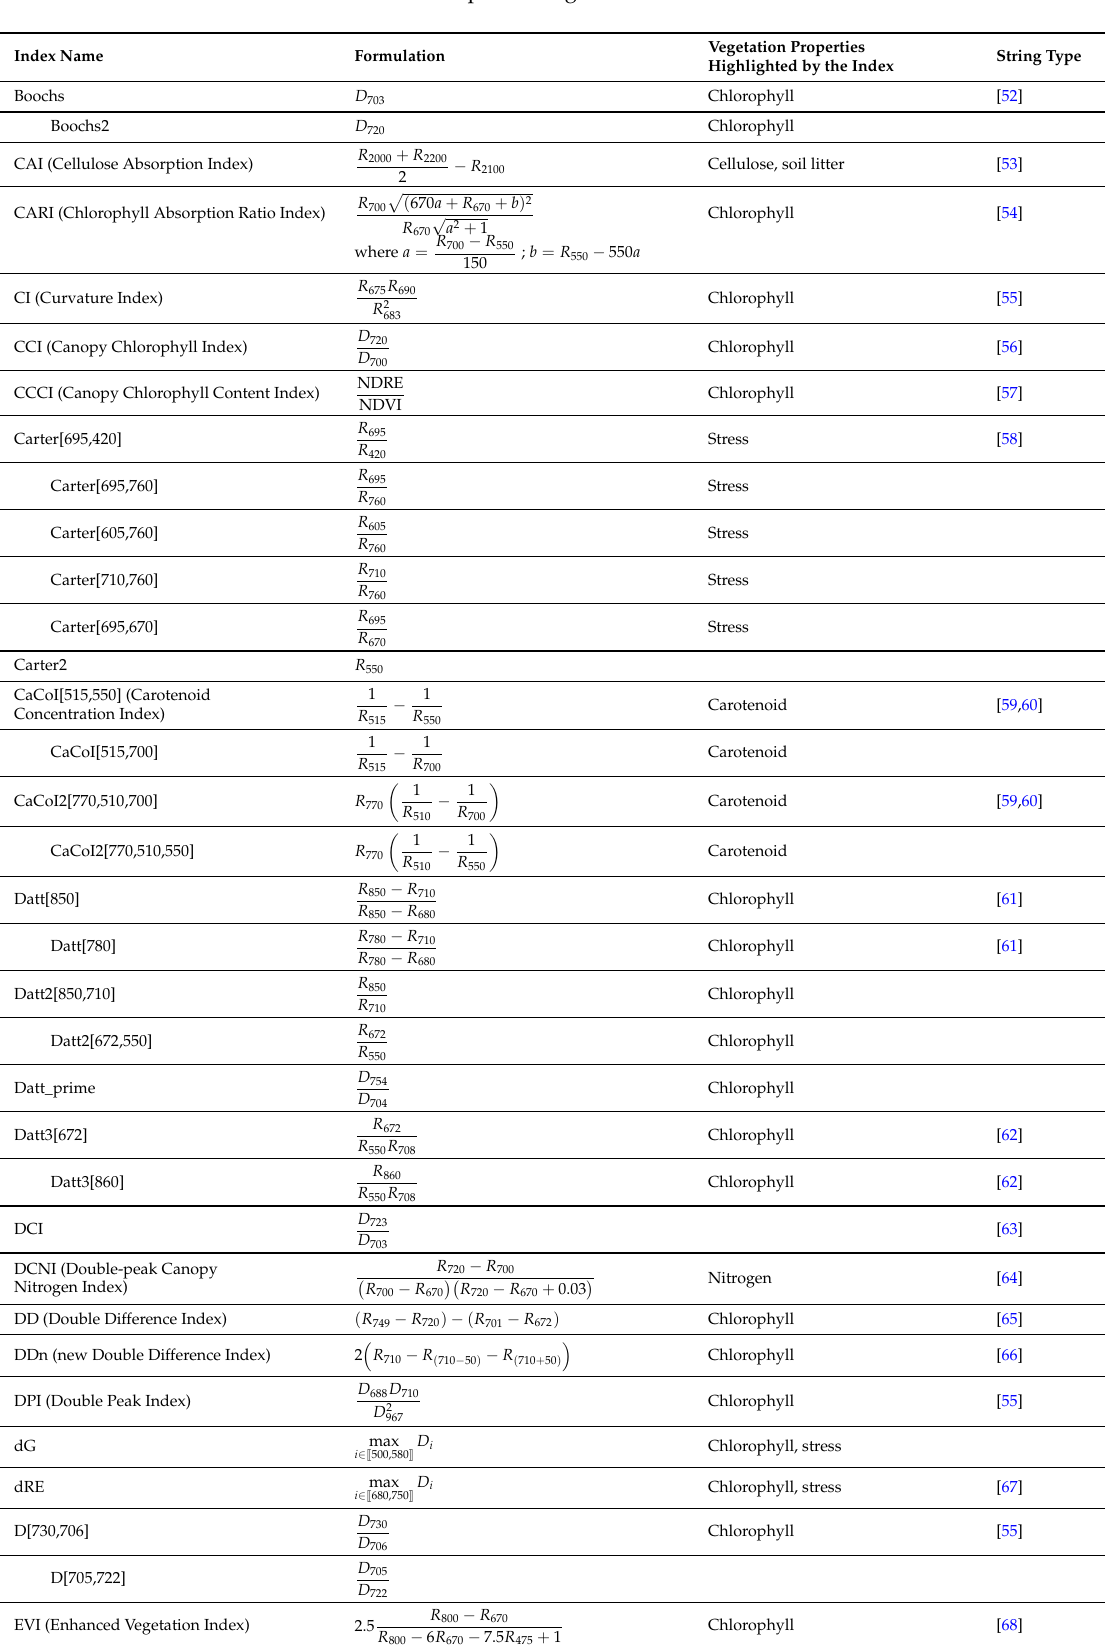
Table 5. Spectral vegetation